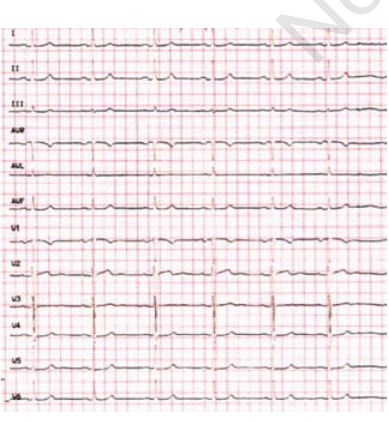
Figure 4. Family tree. The proband is shown as a black circle (arrow). Asymptomatic car- Figure 1. Baseline electrocardiogram of the riers of the mutation (cases) are shown as black and white circles and squares index case showing sinus rhythm at 55 (circles=female; squares=male). Family members who did not have the mutation (con- beats per min, normal PR, QRS and QTc trols) are shown as white circles and squares. *S marks the case with syncope. F+ shows intervals and absence of Brugada pattern family members with a positive flecainide test. “Fallot” marks the case excluded from the findings. electrocardiogram and imaging study because of Tetralogy of Fallot. NS, Not